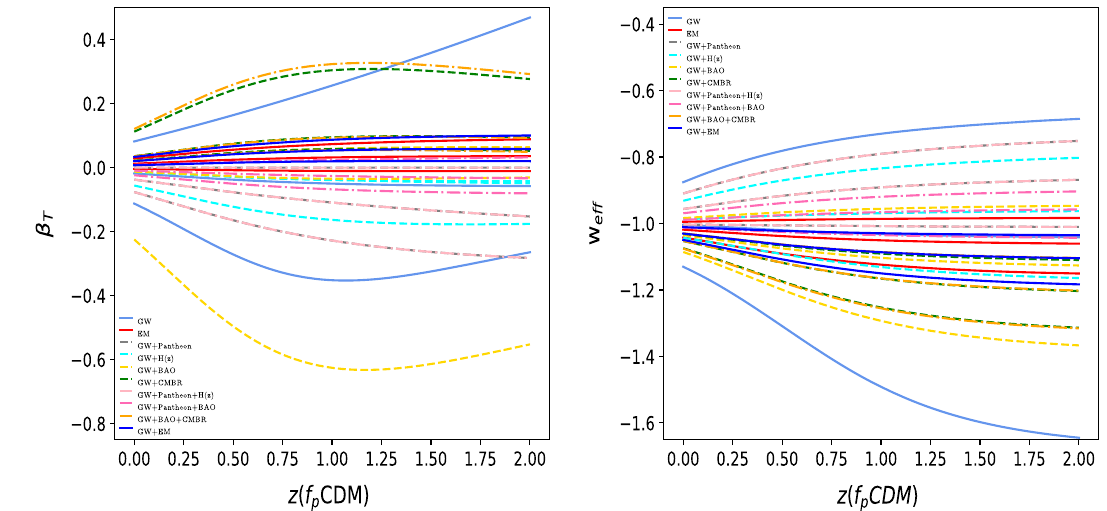
Fig. 4 The evolution of w ef f and β T of the f p CDM model in 1 σ region for the GW, EM and combined data separately